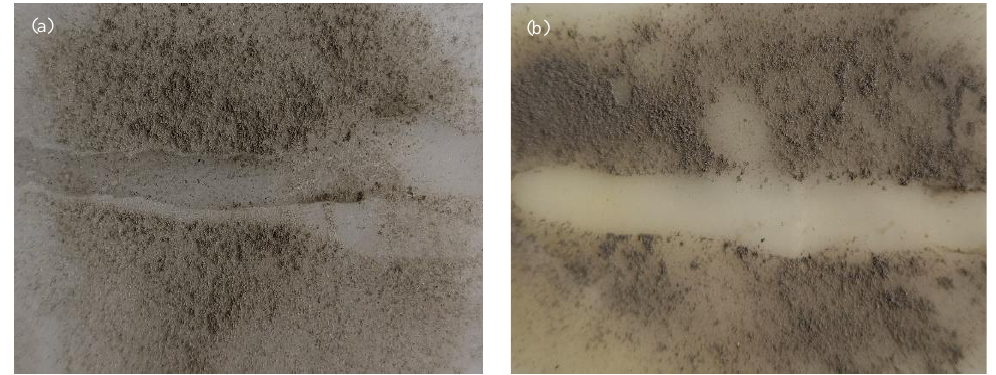
Figure 8. Anti-scaling properties of ( a ) HDPE and ( b ) HPS5 composite.